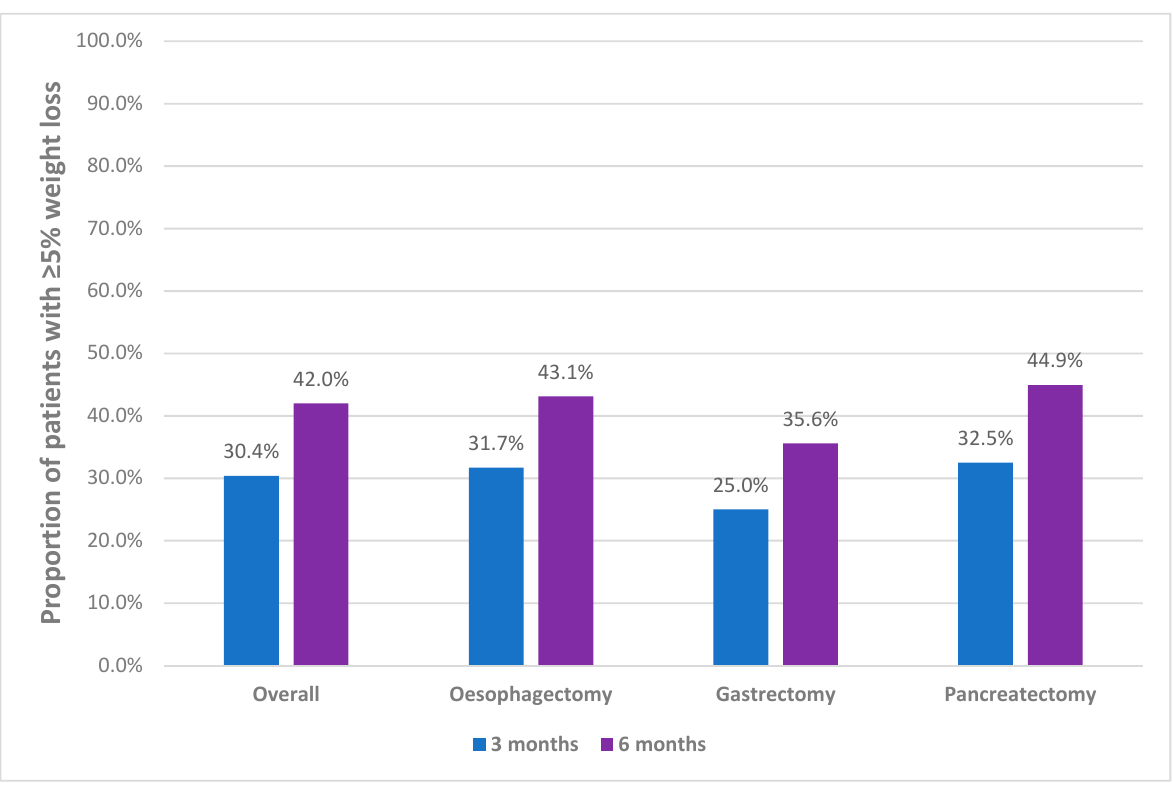
Figure 2. Prevalence of ≥ 5% weight loss in 3 and 6 months.